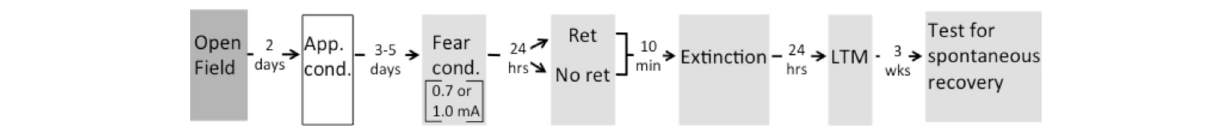
conditioning, rats were exposed to a single cue retrieval trial (Ret) or a typical extinction session (No ret). For rats in the Ret group that received a cue exposure and those in the No ret group that received a context exposure, the exposure occurred 10min prior to beginning the extinction session. 24h after extinction, rats were tested for long-term memory (LTM), and 3 weeks later tested for spontaneous recovery. Context change is indicated by